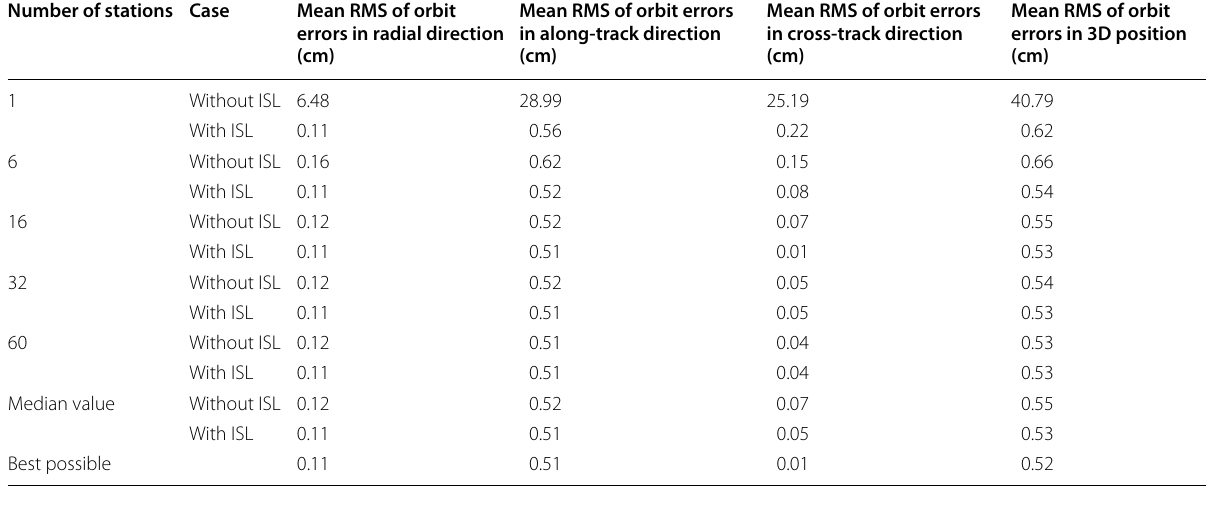
Table 5 Mean RMS of orbit errors in radial, along-track, and cross-track directions, and 3D position for a global network Number of stations Case